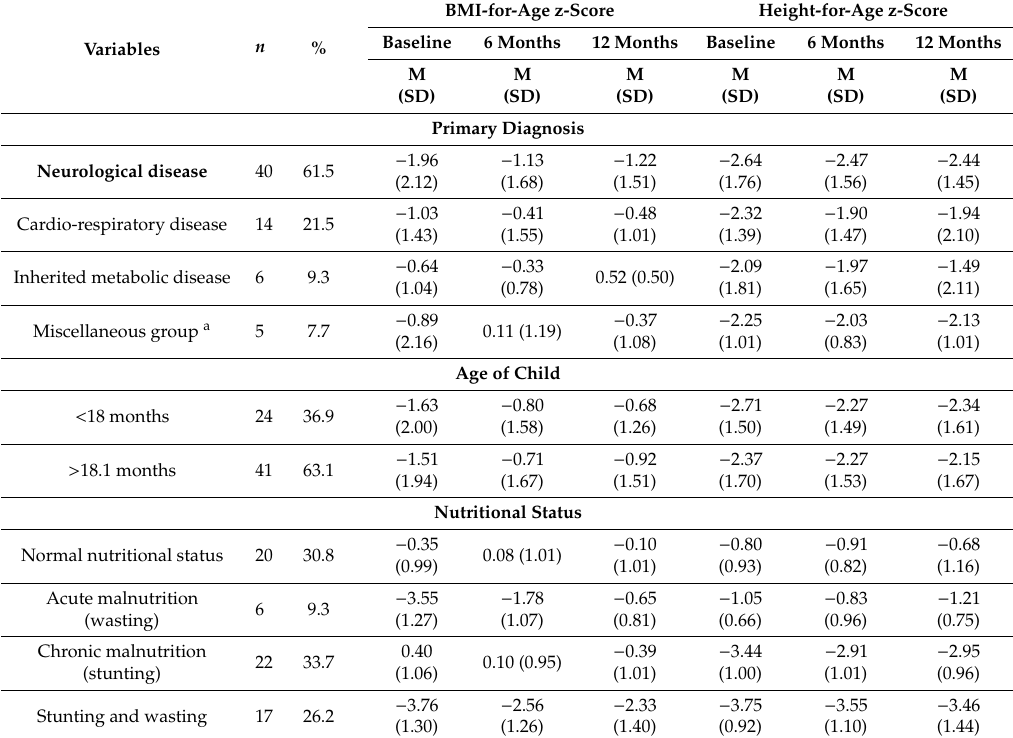
Table 2. Means and standard deviation of BMI-for-age z-score and height-for-age z-score for the three times grouped by the study